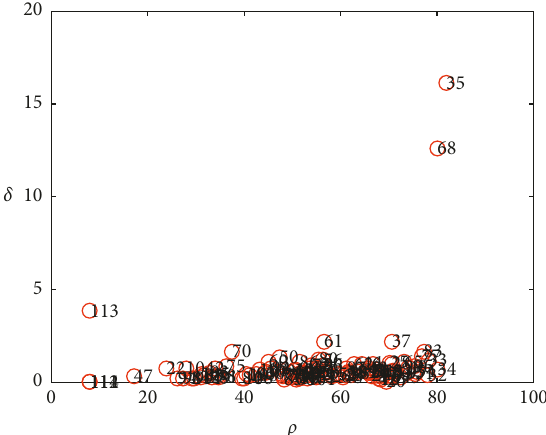
Figure 9: Decision chart for parameters ρ